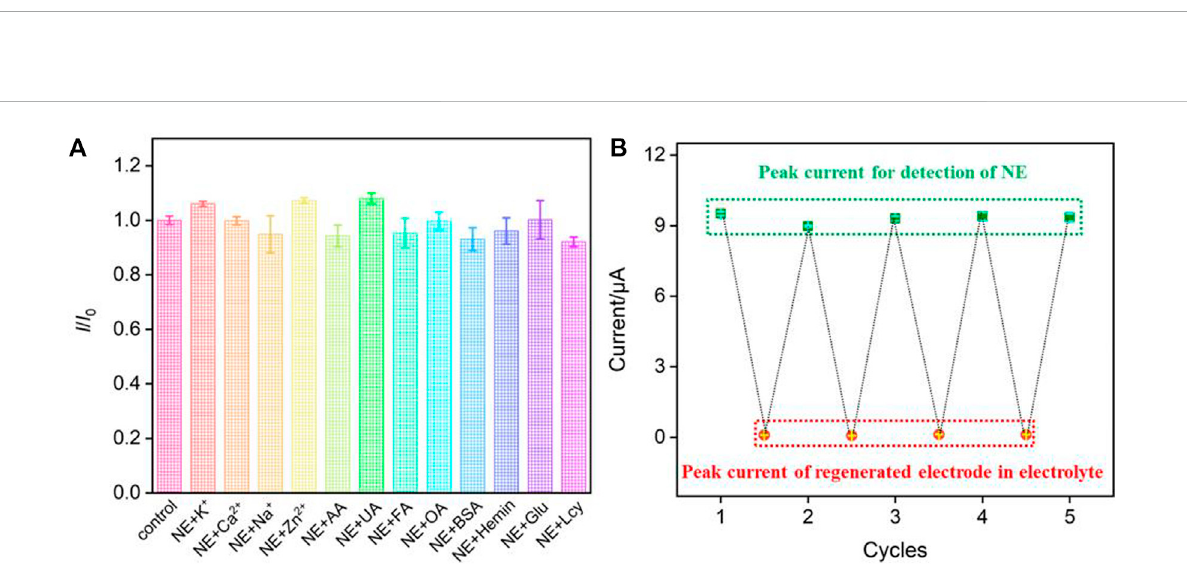
μ M) in the absence ( I I ) of 10-fold (K + , 0 ) and presence (